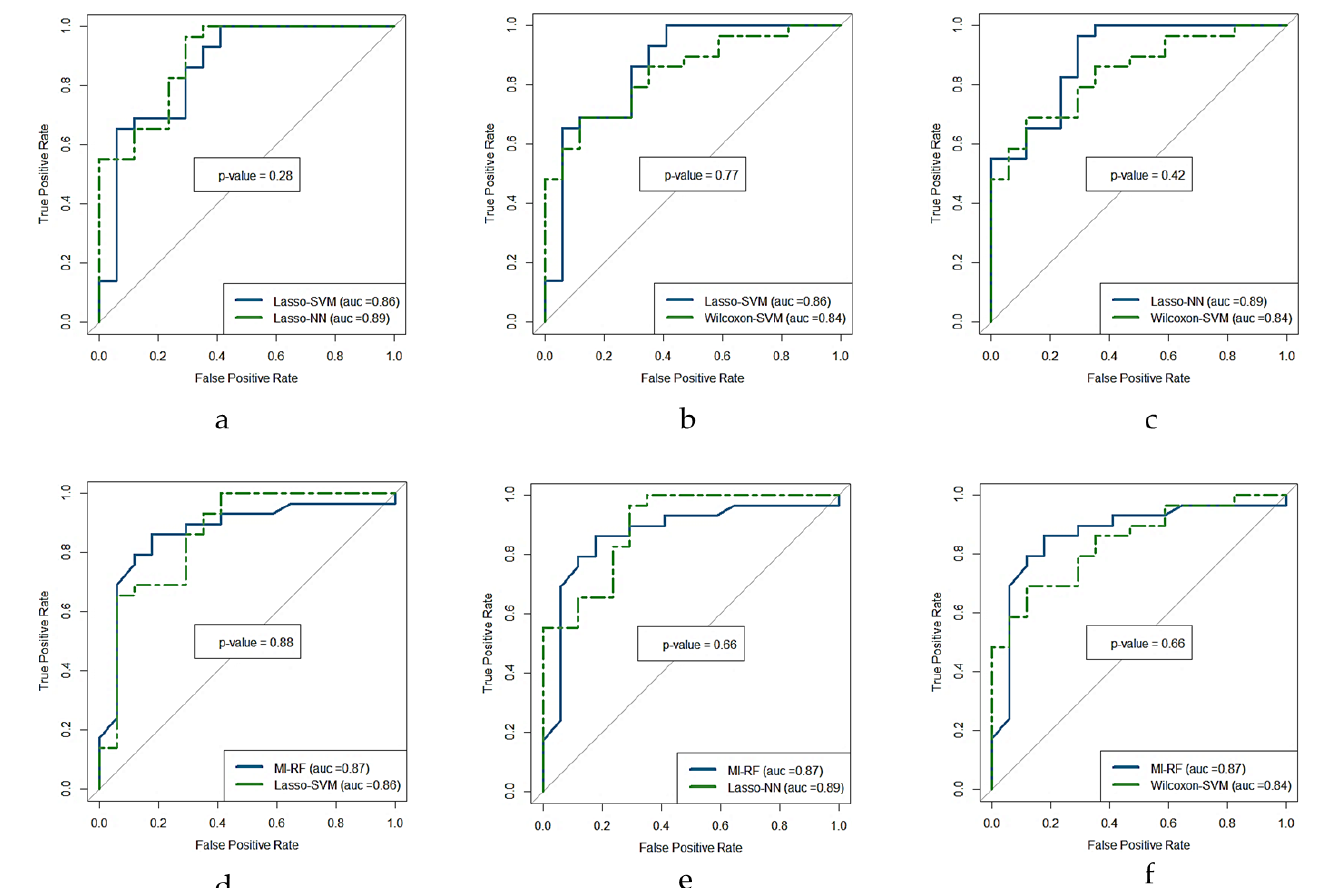
Figure 6. DeLong test ROC curves of the four predictive models with highest performance in